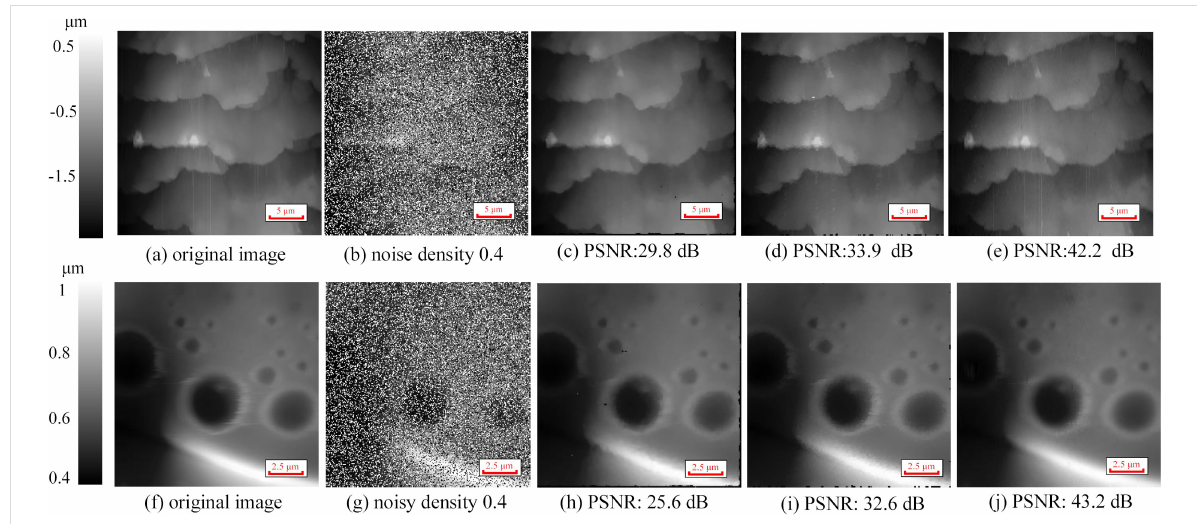
Figure 3: Comparison of denoising between the interval-BCS denoising, the median filter and the adaptive median filter. (a, f) Original images. (b, g) Images with added impulse noise with a density of 0.4. (c) Denoised image obtained by the median filter; the PSNR is 29.8 dB, and the SSIM is 0.92. (d) Denoised image obtained by the adaptive median filter; the PSNR is 33.9 dB, and the SSIM is 0.95. (e) Denoised image obtained by the interval-BCS denoising, where the upper limit is 254 and the lower limit is 5. Here, the PSNR is 42.2 dB, and the SSIM is 0.96. The runtime is 6.7 s. (h) Denoised image obtained by the median filter; the PSNR is 25.4 dB, and the SSIM is 0.93. (i) Denoised image obtained by the adaptive median filter; the PSNR is 32.6 dB, and the SSIM is 0.96. (j)Denoised image obtained by the interval-BCS denoising, where the upper limit is 250 and